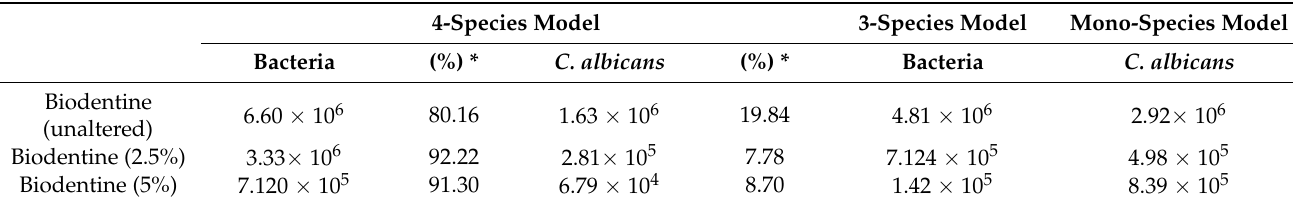
Table 2. Live CFE counts for C. albicans and bacteria and percentage composition in all biofilms following biofilm growth on Biodentine discs.